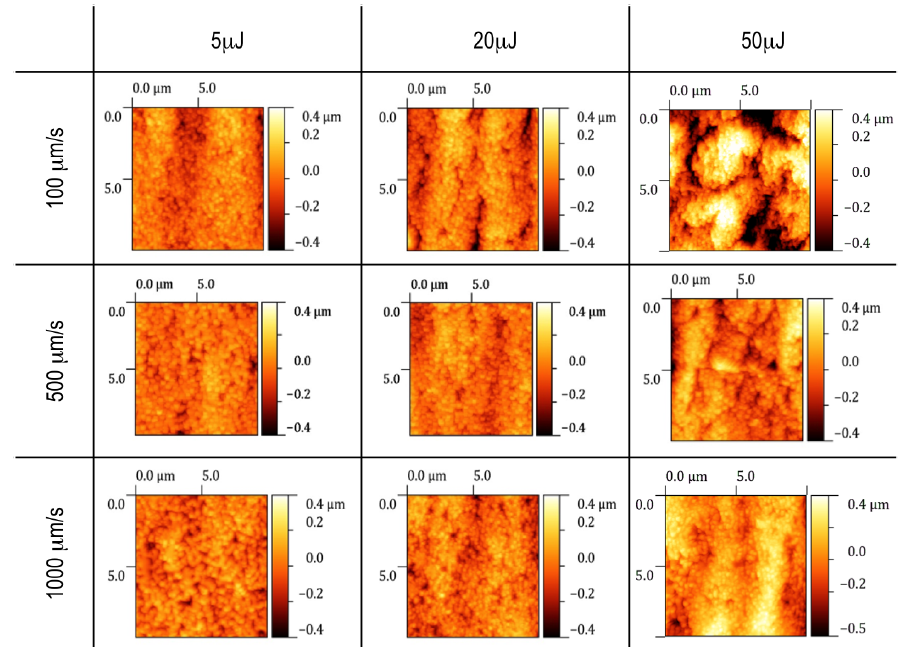
Figure 6. Examples of atomic force microscope (AFM) measurements of 10 × 10 µ m 2 areas on the lateral walls of the microfluidic test channels engraved by laser ablation at different pulse energies and scanning speeds. The colour scale is the same for all of the images in order to highlight the dependence of the surface morphology on the process